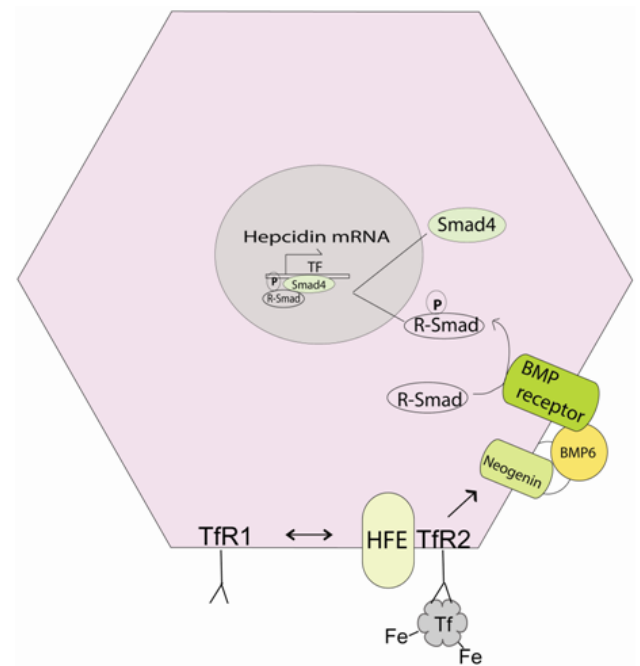
Figure 1. Overview of the SMAD/BMP pathway in hepatocytes. Iron-saturated transferrin acts like a hepcidin transcription switch. Low levels of iron-saturated transferrin destabilizes the TfR-HFE complex, preventing the phosphorylation of R-SMAD, which represses hepcidin